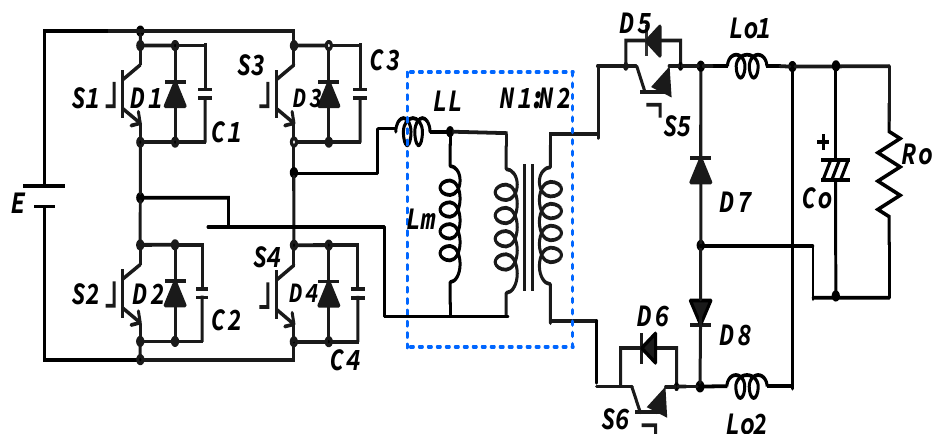
Figure 2. Proposed pulse width modulation (PWM) phase-shift direct current (DC)–DC converter circuit with an active switch current doubler rectifier.